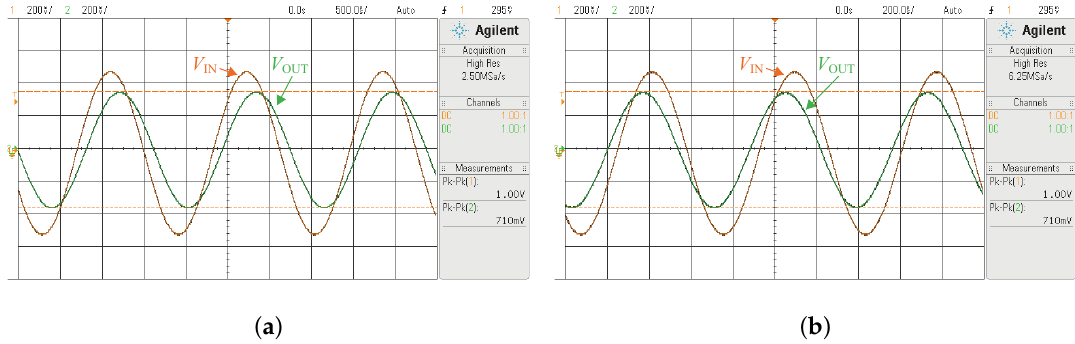
Figure 13. Input–output waveforms observed in oscilloscope for the proposed BSPLF ( α = 0.5 ) with an input frequency of ( a ) f H,low = 614 Hz and ( b ) f H,high = 1.47 kHz.